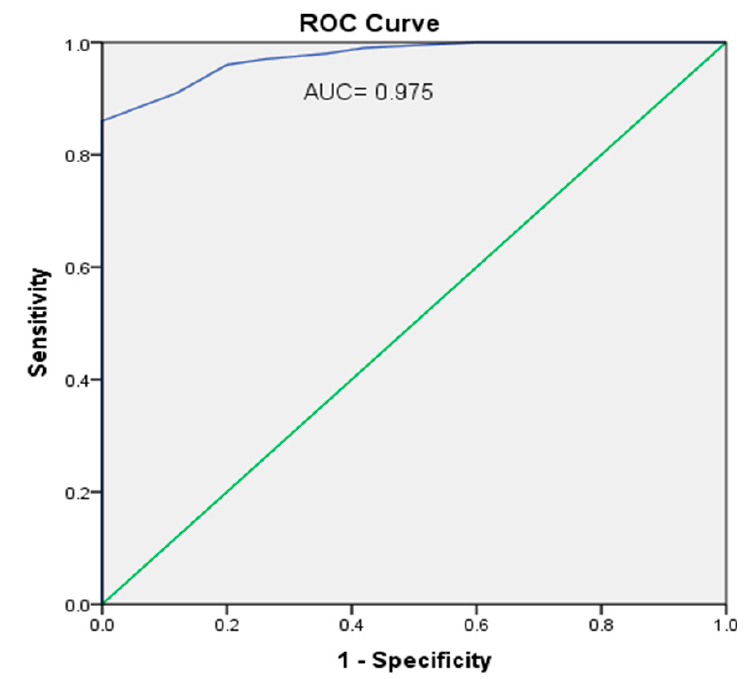
Figure 4. ROC curve shows area under the curve (AUC = 0.975). The optimal cut-off point for a relative SIRT1 level was 2.55 with a sensitivity of 91%, a specificity of 88% and Youden index = 178.